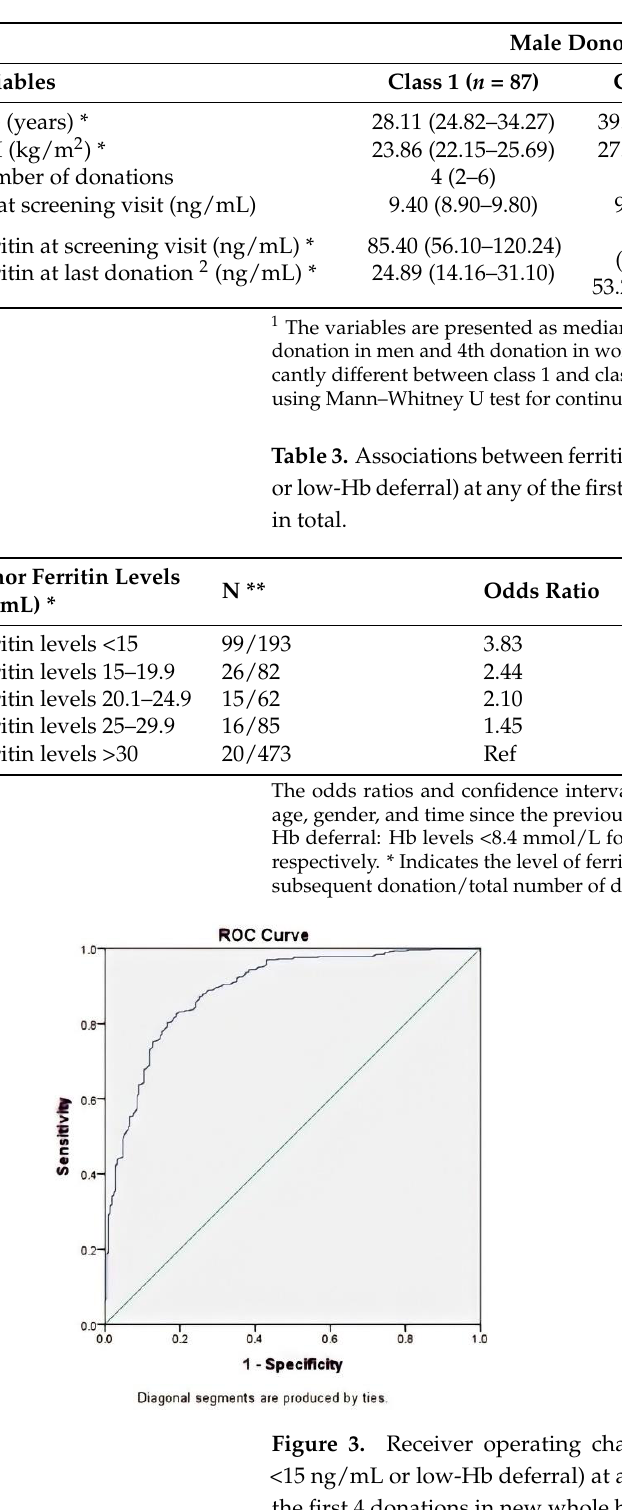
Table 2. Descriptive of donors in the FIND+ dataset by gender and group-based trajectory of the growth mixture model. 1